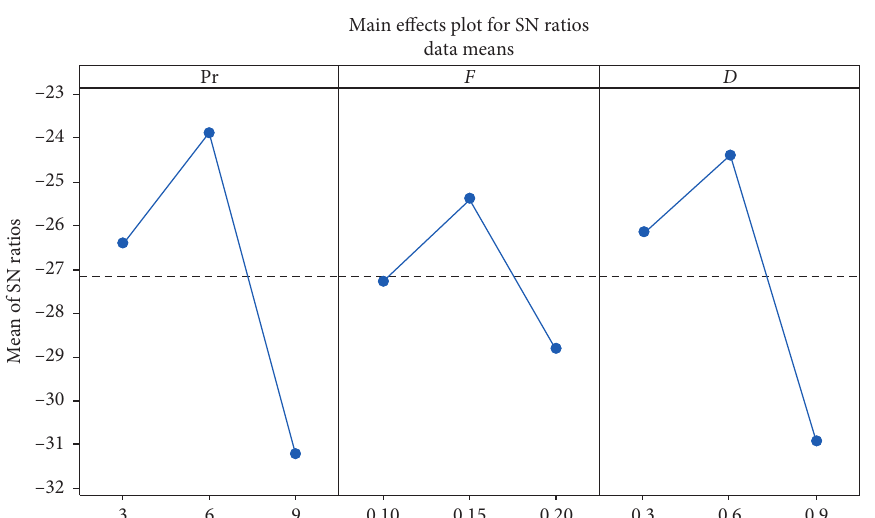
Figure 11: Tool wear, surface roughness, and thrust force focused the important diagram-based on the ratio of SN; in the X -axis, pressure of cutting fluid, Pr (bar), feed, F (mm/rev), and depth of cut, D (mm). frequencies. The versus order plot gives the reliability of the Figure 13. The normal probability plot provides the closeness experiment results with more than half of the experiment of the point to the median line; similarly, versus fits men- counts. Then, Table 8 provides the SN ratio and mean-based tioned the distraction of the points away from the center. outcomes in each trail of the four combinations. The histogram has the gapped vertical columns’ shape with